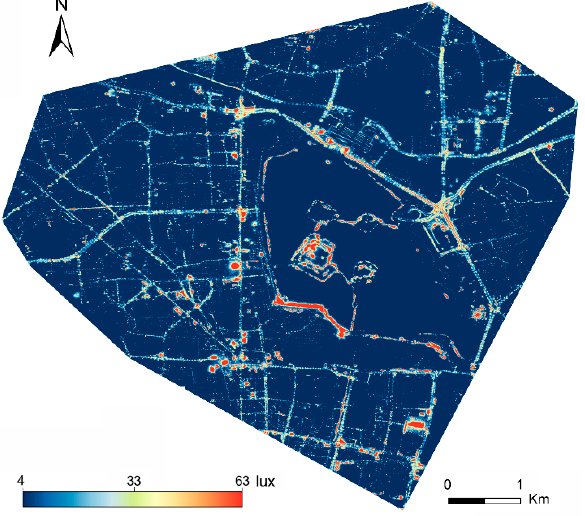
Figure 9. Illuminance map.